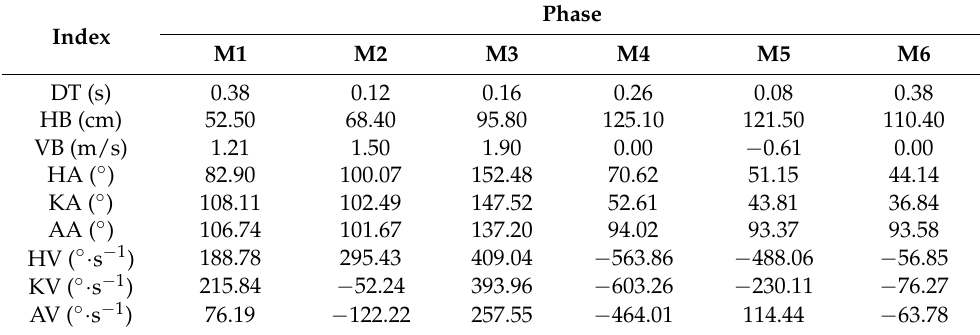
Table 1. Kinematic performance of the barbell during the snatch (M1 was from the start position to the instant of the first maximal knee extension angle; M2 was the instant of the knee angle from maximum to minimum; M3 was from the end of M2 to the maximal vertical rising velocity of barbell; M4 was from the end of M3 to the maximal vertical height of barbell; M5 was from the end of M4 to the maximal vertical falling velocity of barbell; M6 was from the end of M5 to squat position. DT is the time of each stage, HB is the vertical height of the barbell at the end of each phase, VB is the maximal vertical velocity of the barbell in each phase, HA the is flexion and extension angles of the hip, KA the is flexion and extension angles of the knee, AA is the flexion and extension angles of the ankle, HV is the angular velocity of hip joint, KV is the angular velocity of the knee joint, AV is the angular velocity of the ankle joint).